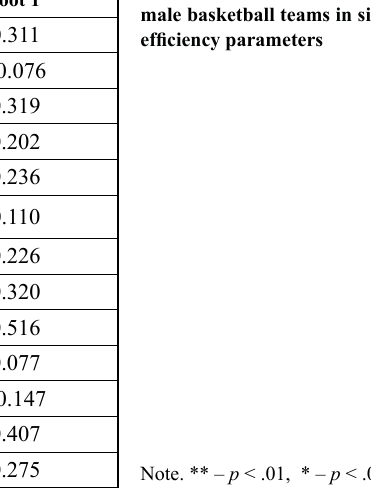
Table 4. Discriminant differences between successful and unsuccessful male basketball teams in situational efficiency